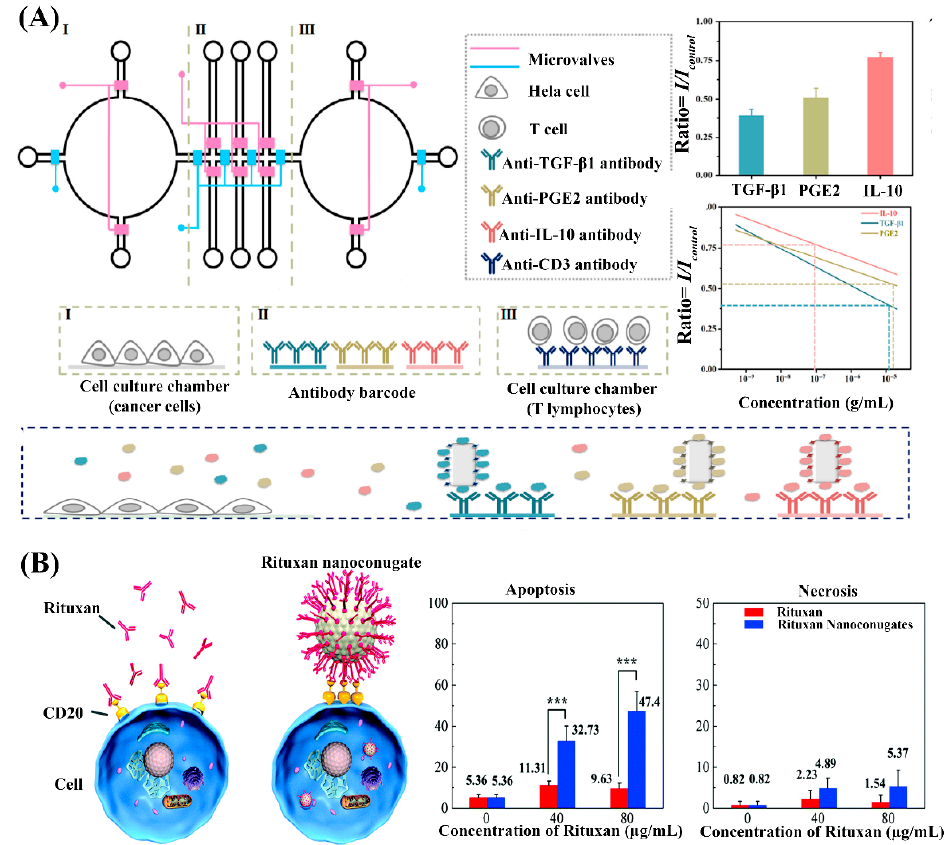
Figure 4. ( A ) Quantitative and multiplexed screening of immunosuppressive proteins (TGF- β 1, PGE2, and IL-10) by a combination of SERS nanoprobes with microfluidic networks. Reproduced from [76], with permission from Springer, 2017. ( B ) Enhanced capping mechanism of CD20 molecules by nanoconjugation of Rituxan to SERS-active silver nanoparticles (Left). Rituxan nanoconjugates induce more apoptosis and necrosis in lymphoma cells than unconjugated Rituxan (Right). Reproduced from [77], with permission from the Royal Society of Chemistry, 2017.